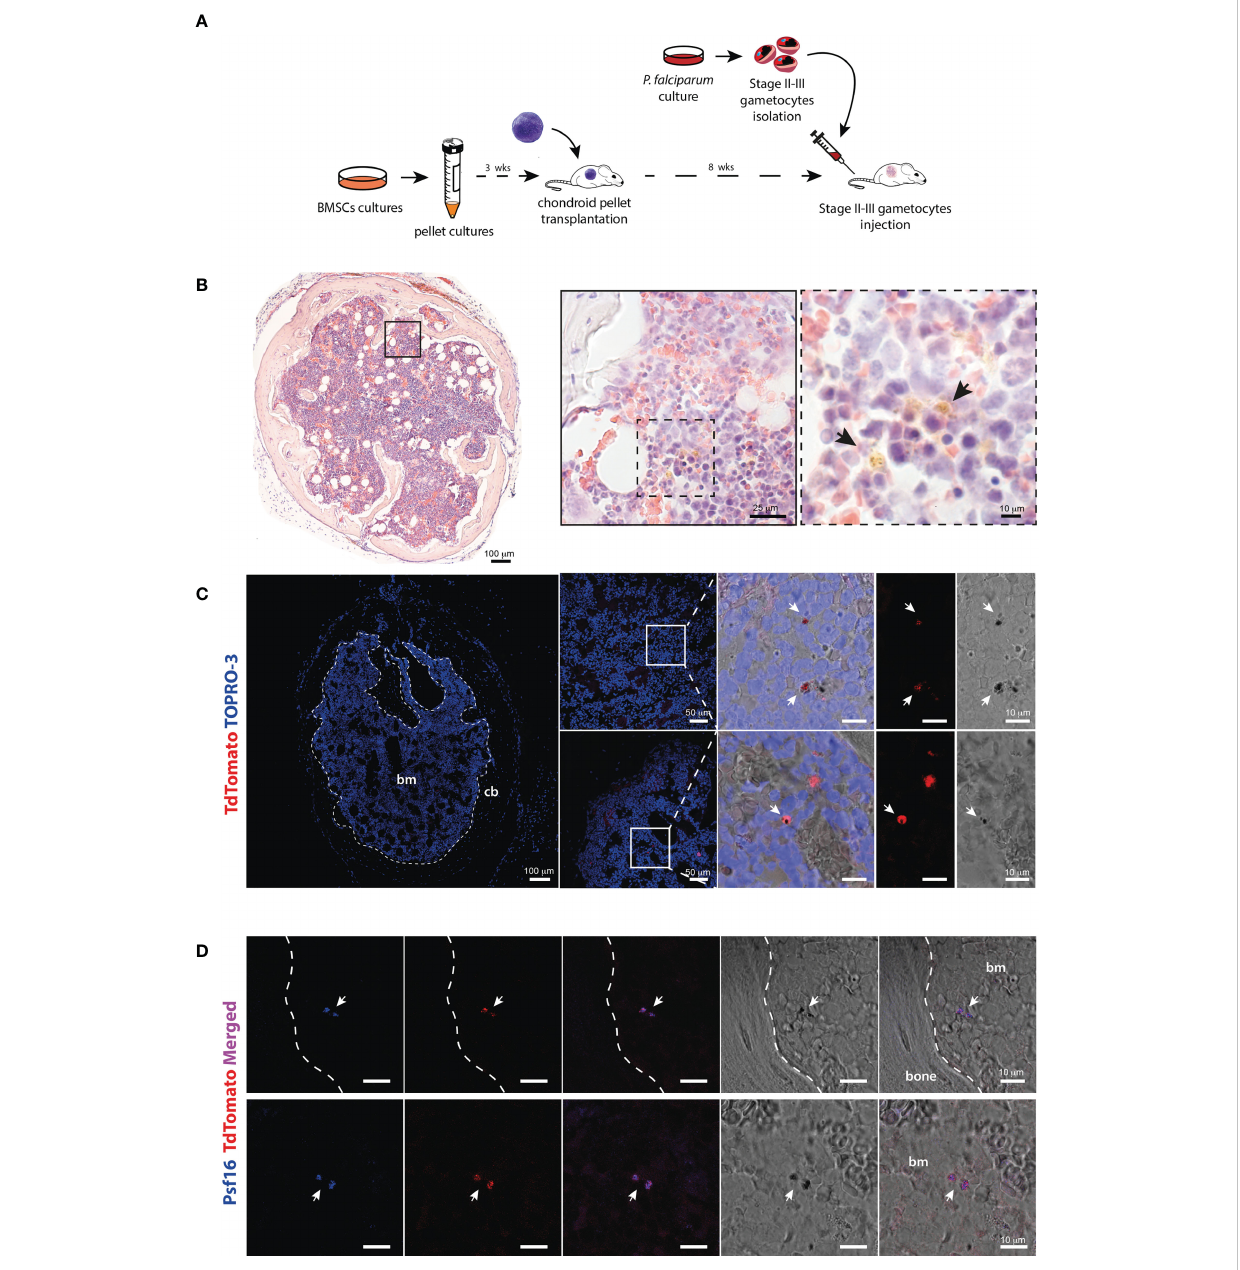
FIGURE 2 Identi fi cation of P. falciparum stage II-III gametocytes in the chimeric ossicle (A) Schematic representation of the experimental procedure for the generation of BM humanized mouse model and injection of Stage II-III gametocytes. (B) H&E-stained ossicle section showing the presence of black-brown pigmented structures consistent with hemozoin in the marrow (arrows). (C) Confocal fl uorescent microscopy images showing the presence of TdTomato positive and pigmented structures within the bone marrow ossicle (white arrows). (D) Immunostaining for the gametocyte speci fi c protein Psf16 con fi rming the presence of stage II-III gametocytes. Fluorescent images show overlapping signal of antibody anti-Psf16 (blue), TdTomato (red) and black pigments. All the ossicles were harvested 10 minutes after gametocytes injection. bm, bone marrow; cb, cortical